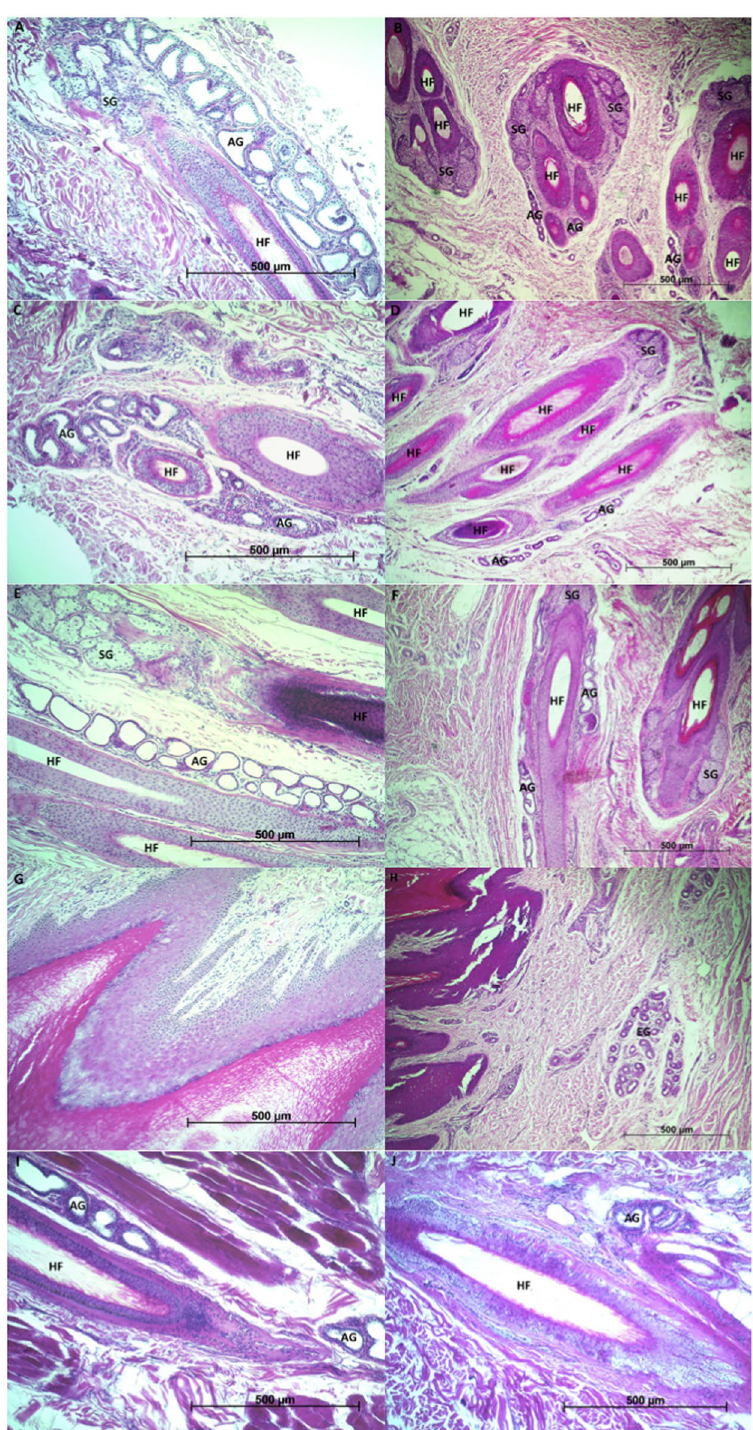
Figure 1. Histological sections of interdigital skin of front paw in adult male ( A ), interdigital skin of front paw in yearling male ( B ), interdigital skin of hind paw in adult male ( C ), interdigital skin of hind paw in yearling male ( D ), ventral metatarsal skin in adult male ( E ), ventral metatarsal skin in yearling male ( F ), front footpad in adult male ( G ), front footpad in yearling male ( H ), and control lip skin ( I ) and control left shoulder skin ( J ) in adult male brown bear ( Ursus arctos ). In interdigital and metatarsal regions ( A , B , C , D , E , F ) there are hair follicles (HF) visible with apparently more profuse and prominent apocrine sweat glands (AG) in adult male ( A , C and E ). In sections of control skin of the adult male ( I and J ), apocrine sweat glands appear less profuse than in sections of the focus areas of the paws. Sections of footpads ( G and H ) show the stratified squamous keratinized epithelium of the pad with very thick striatum corneum (the darkest shade of stain), and eccrine glands (EG) deeper in the dermis of yearling male ( H ). Stain: hematoxylin and eosin. Magnification: x100. SG – sebaceous